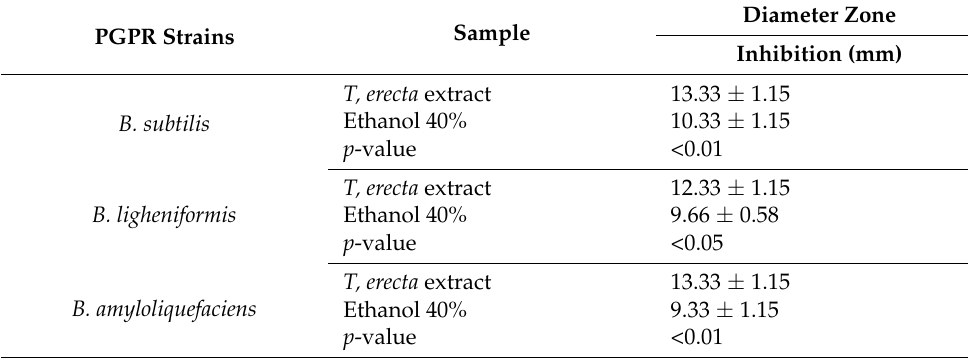
Table 4. Comparative qualitative evaluation of antibacterial activity between T. erecta extract and the solvent (40% ethanol) against PGPR